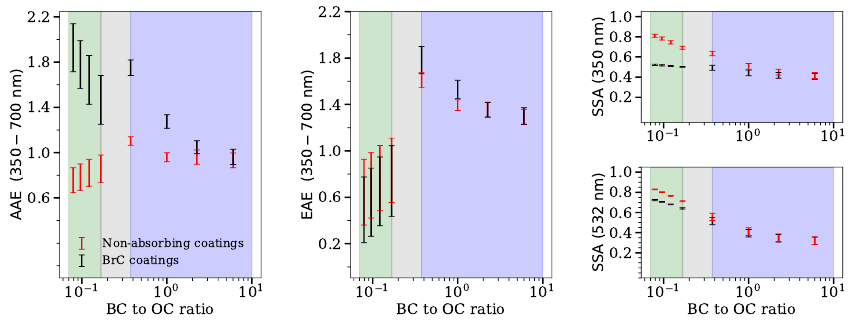
Figure 3. Similar to Figure 2, but D f = 2.6 for thinly-coated